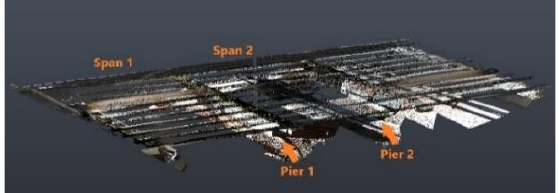
Figure 5. An overview of the Kapooka bridge (white and shadow point cloud are from two different laser scanners).